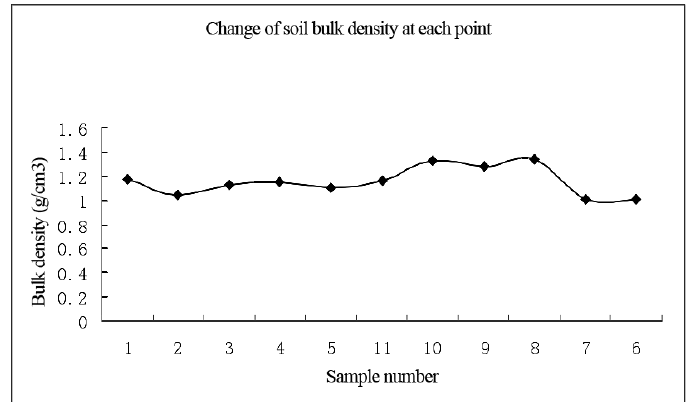
Figure 3. Changes in soil bulk density.